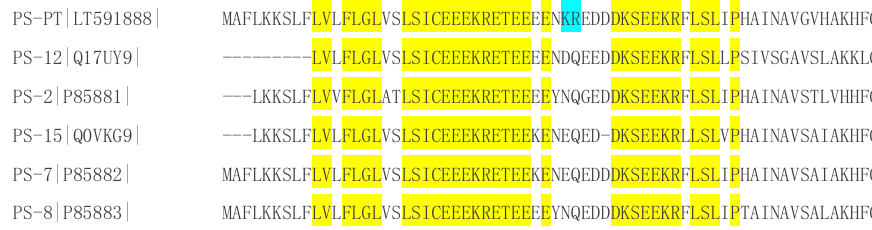
Figure 7. Alignment of precursors of PS-PT and other phylloseptin peptides isolated from Phyllomedusa hypochondrialis azurea . Consensus residues are highlighted in yellow and specific sign is indicated in blue.